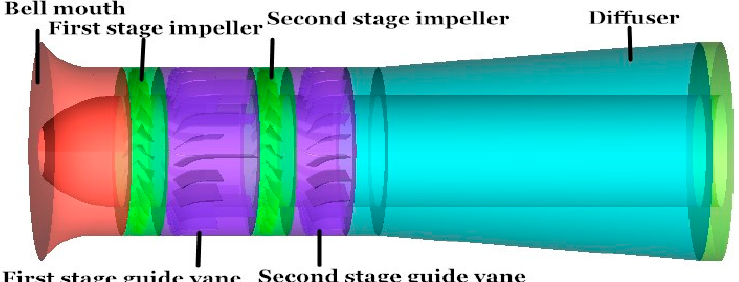
Figure 1. Geometry model of the axial fan.